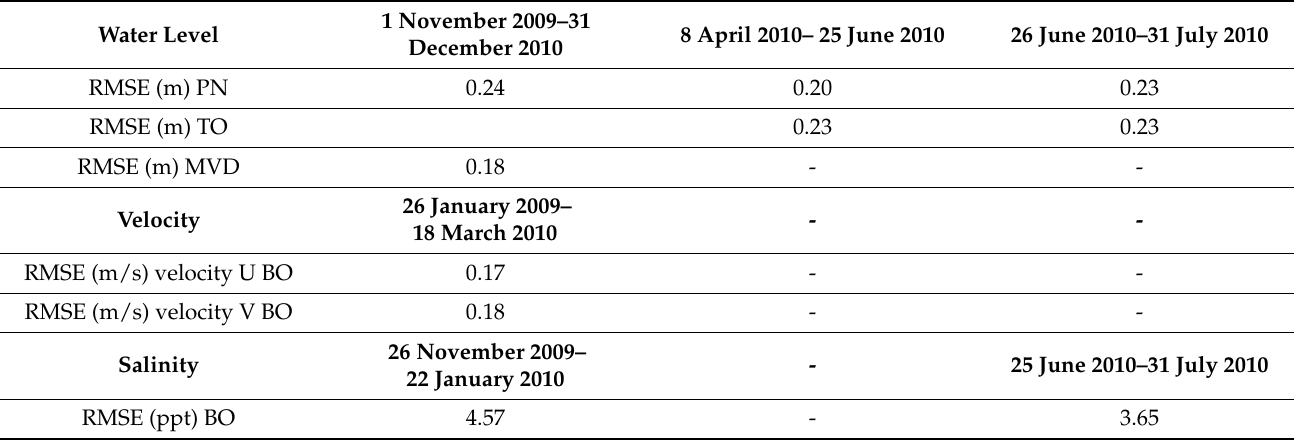
Table A3. Statistics obtained during the validation stage for water levels at PN, TO, and MVD; velocity currents at BO; and salinity at BO. The periods of time used for the comparison between data and model are